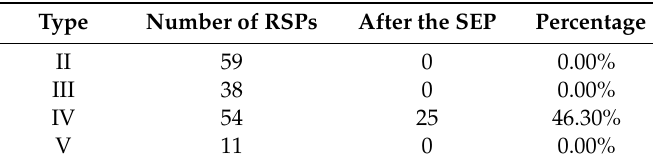
Table 4. Percentage of RSPs occurring after the